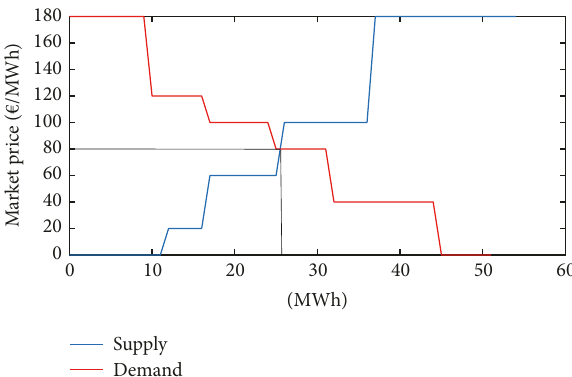
Figure 1: Aggregated bid-offer curves and market